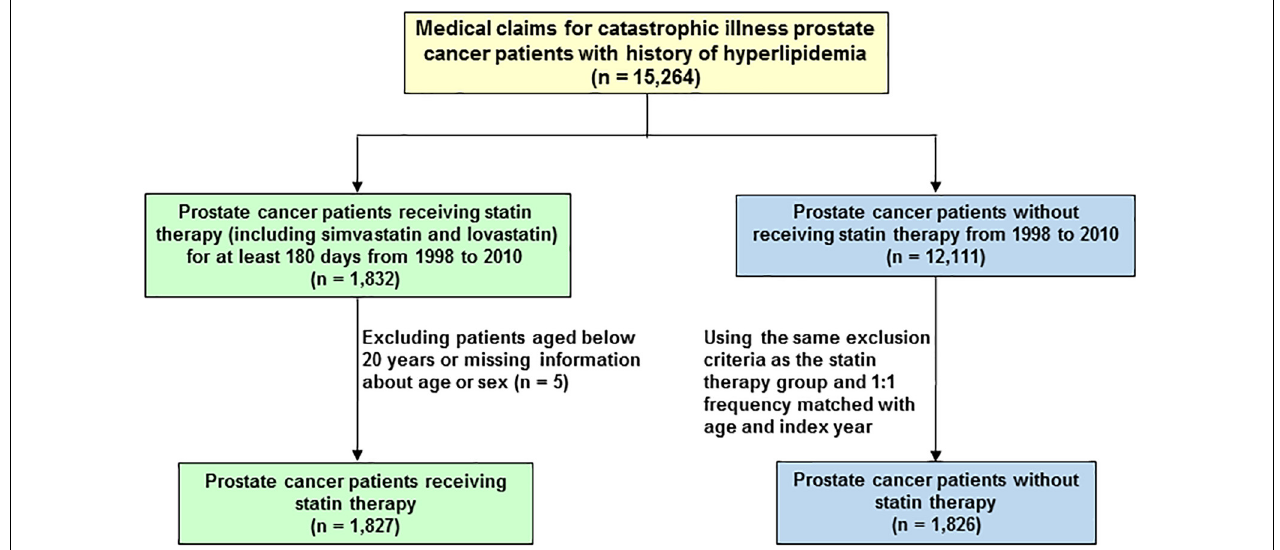
FIGURE 1 | Flowchart of the establishment of cohorts, patient selection, identification, and analysis.